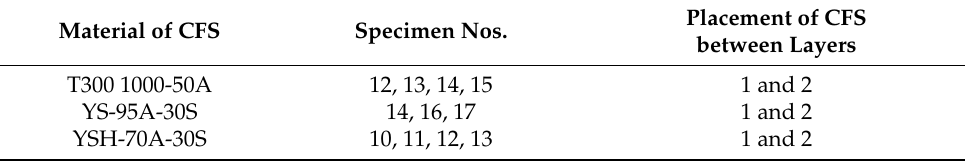
Table 3. Overview of the specimens for temperature tests. Material of CFS Specimen Nos.